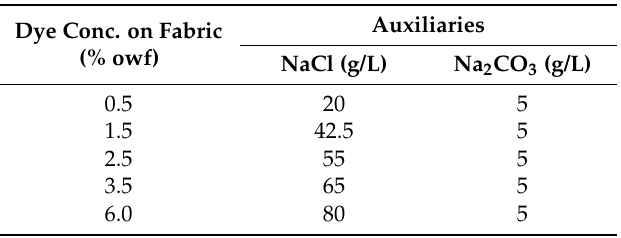
Table 1. Dye recipe for calibration dyeing. (% owf, percentage on weight of